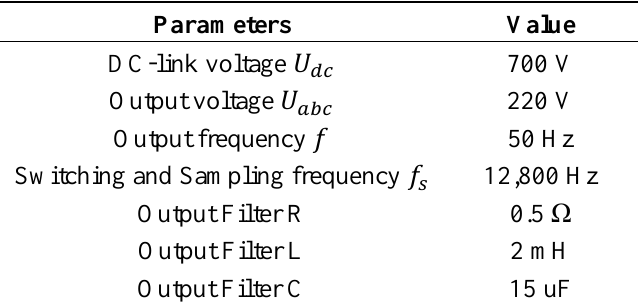
Table 2. Parameters of